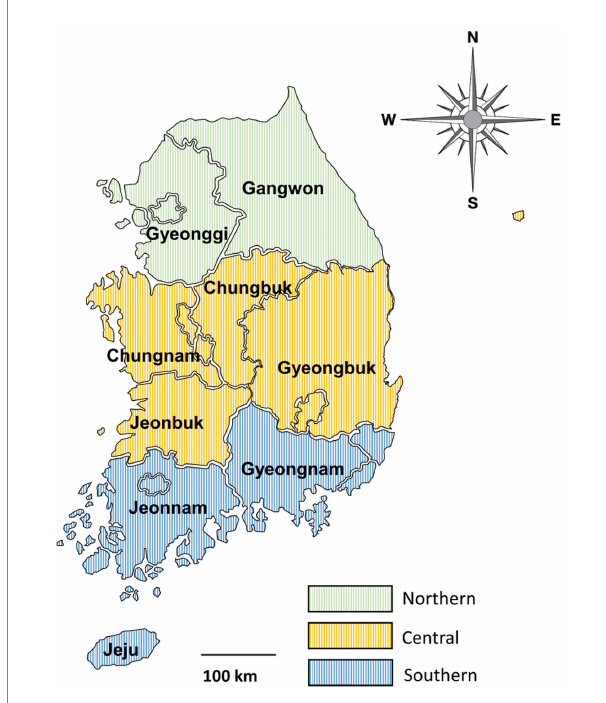
FIGURE 1 Map of the sample collection regions. The country was divided into three regions based on the boundaries of administrative districts as follows: northern (provinces of Gangwon and Gyeonggi), central (provinces of Chungbuk, Chungnam, Gyeongbuk, and Jeonbuk), and southern (provinces of Gyeongnam, Jeju, and